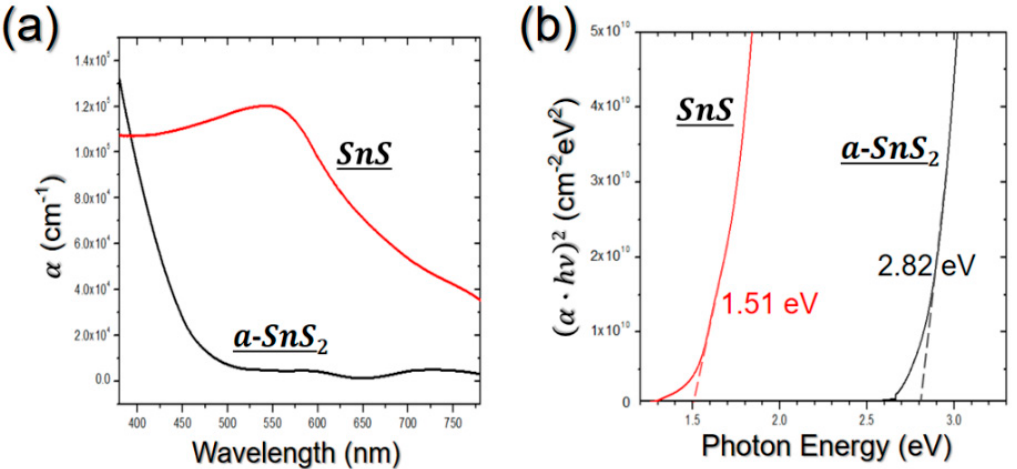
Figure 3. Optical properties of a-SnS 2 film and the SnS film: ( a ) absorption coefficient in the visible region and ( b ) ( α h ν ) 2 plot to determine the optical bandgap.